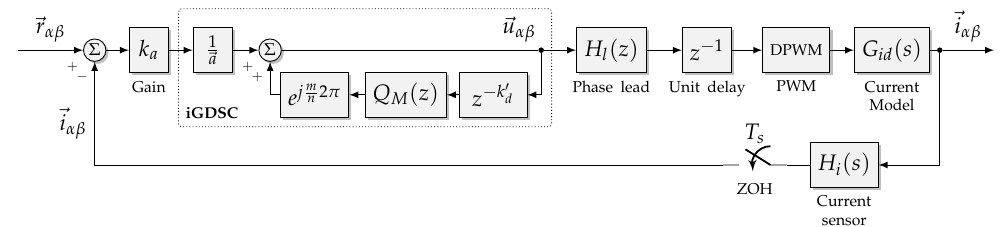
Figure 5. Block diagram of iGDSC based SV-RC with positive feedback structure.